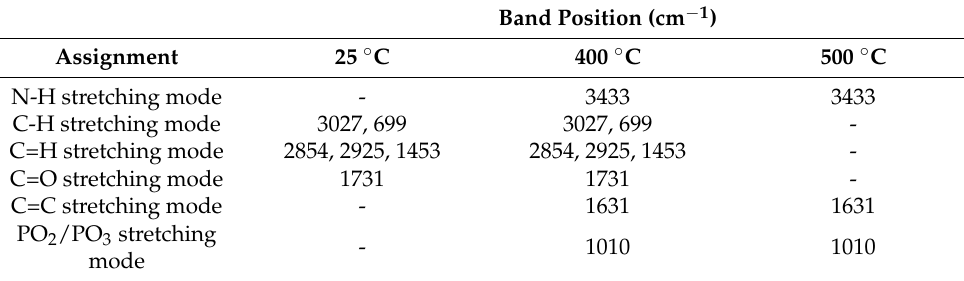
Table 5. The assignments of the characteristic vibration peaks of MPP/PAPP-IC